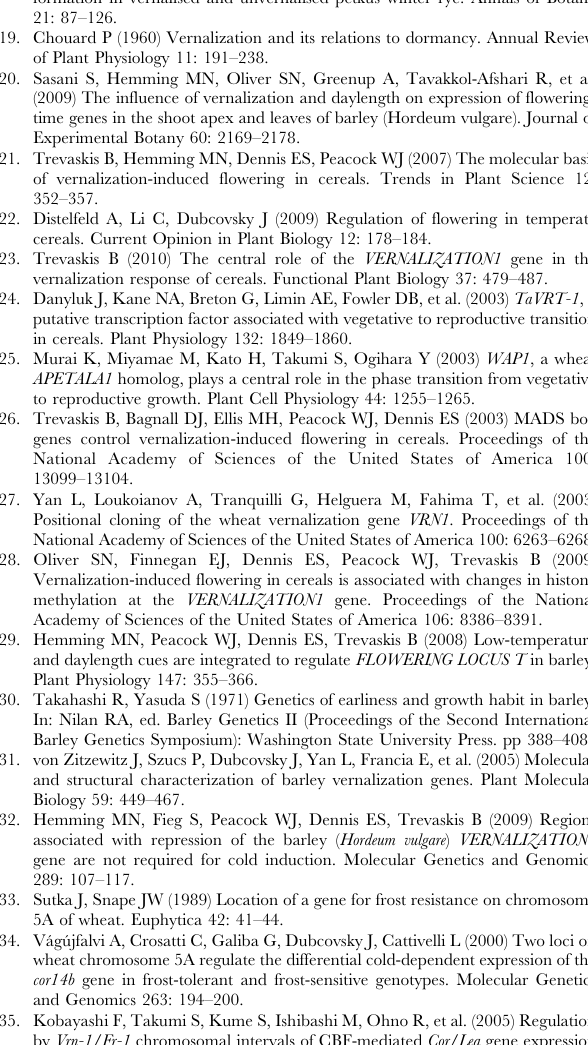
Table S8 Contigs with altered expression in the leaves of barley plants after vernalization.